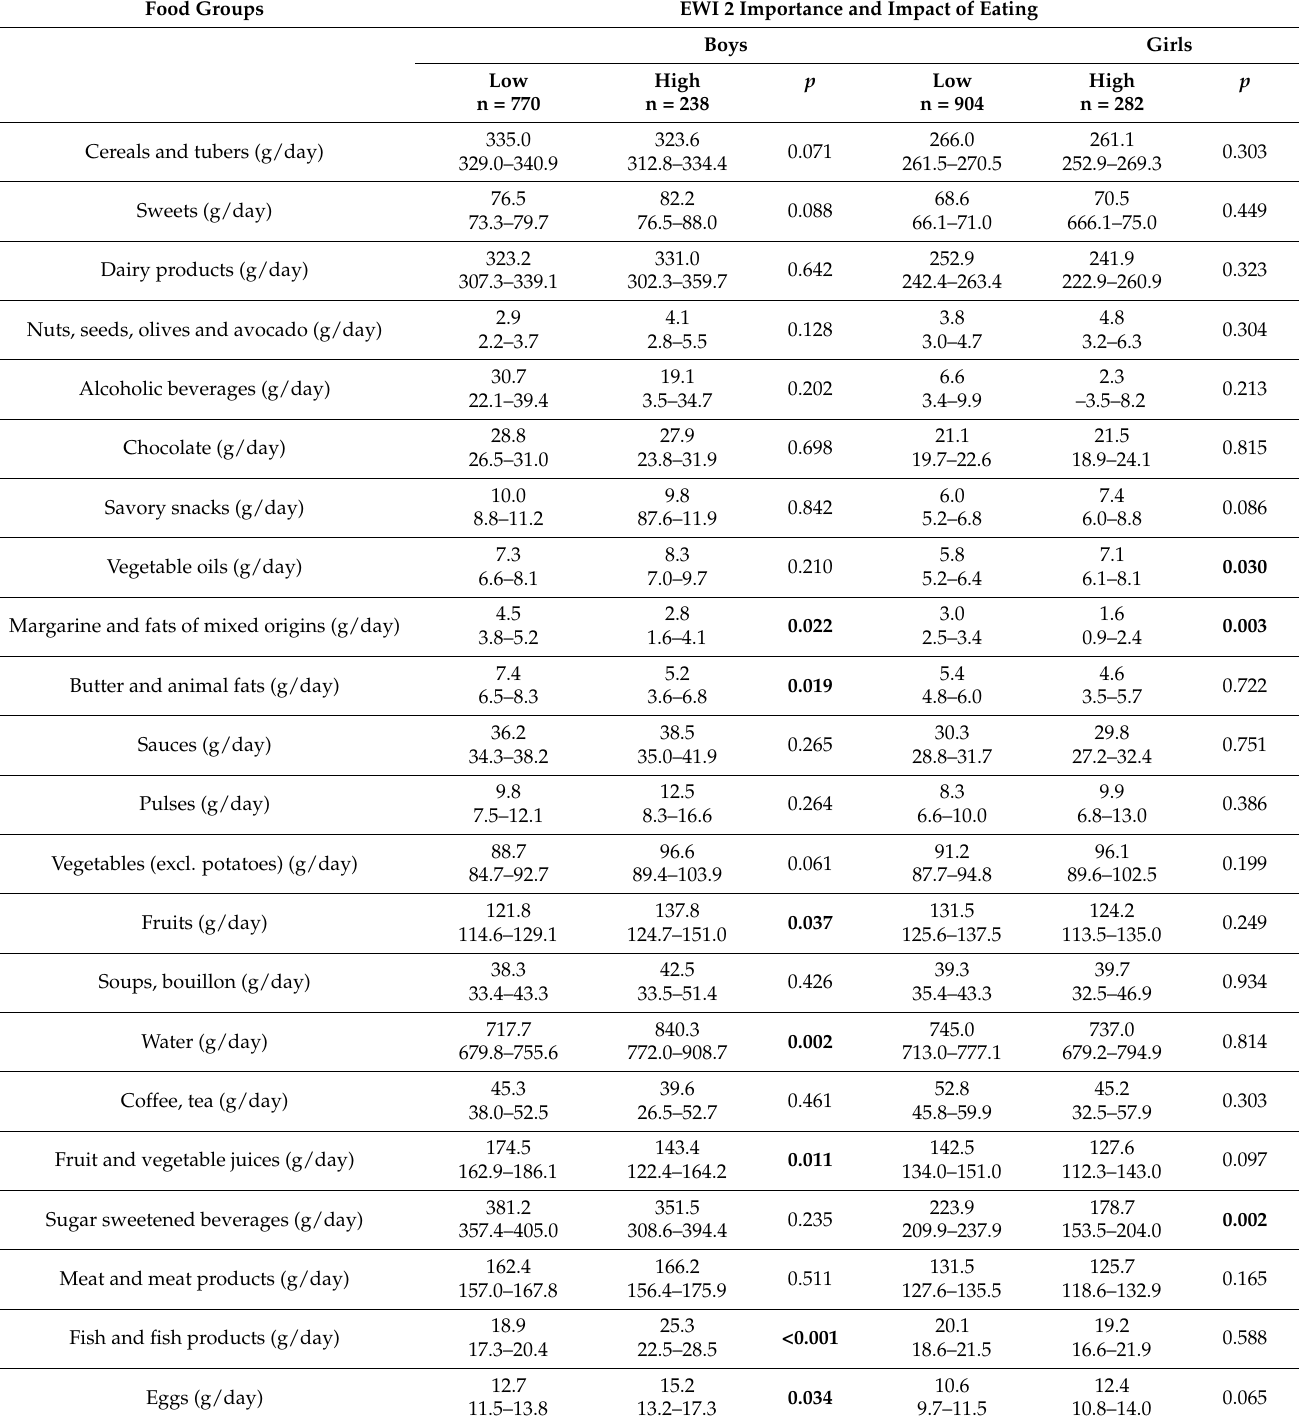
Table 3. Mean (95% CI) intake of food groups by levels of the Importance and impact of eating component (EWI 2) in adolescents from the HELENA